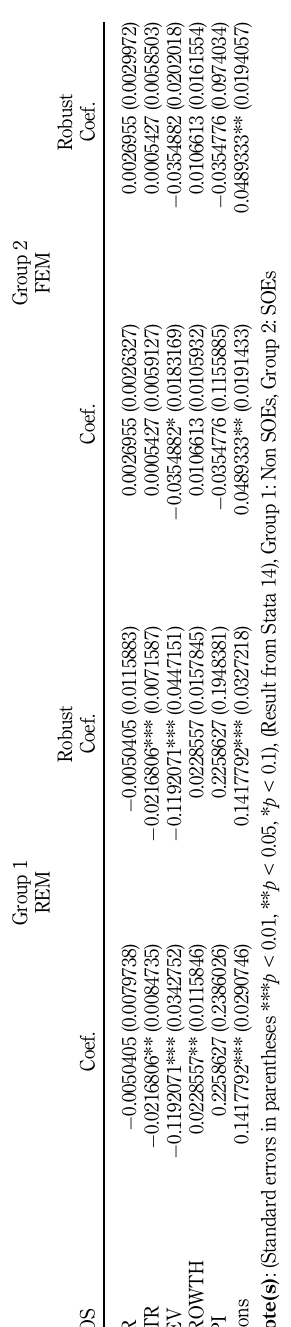
Table 9. Regression